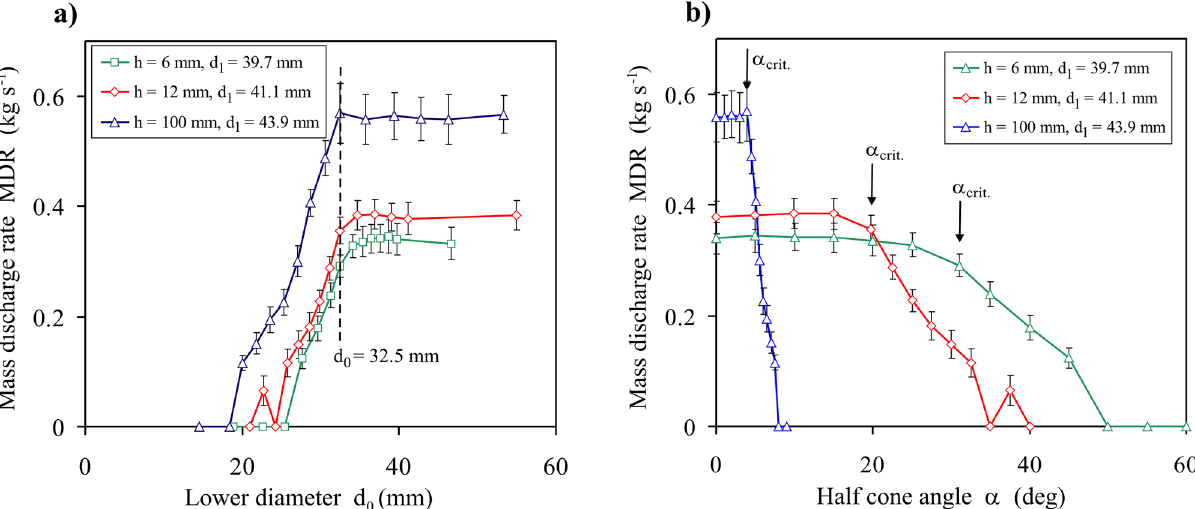
Figure 7. Mass discharge rate MDR vs.: ( a ) the lower diameter of the orifice d 0 , ( b ) the half cone angle of the orifice α for three different values of the thickness h of the converging orifice and the upper diameter d 1 providing maximum MDR for d 0 = 32.5